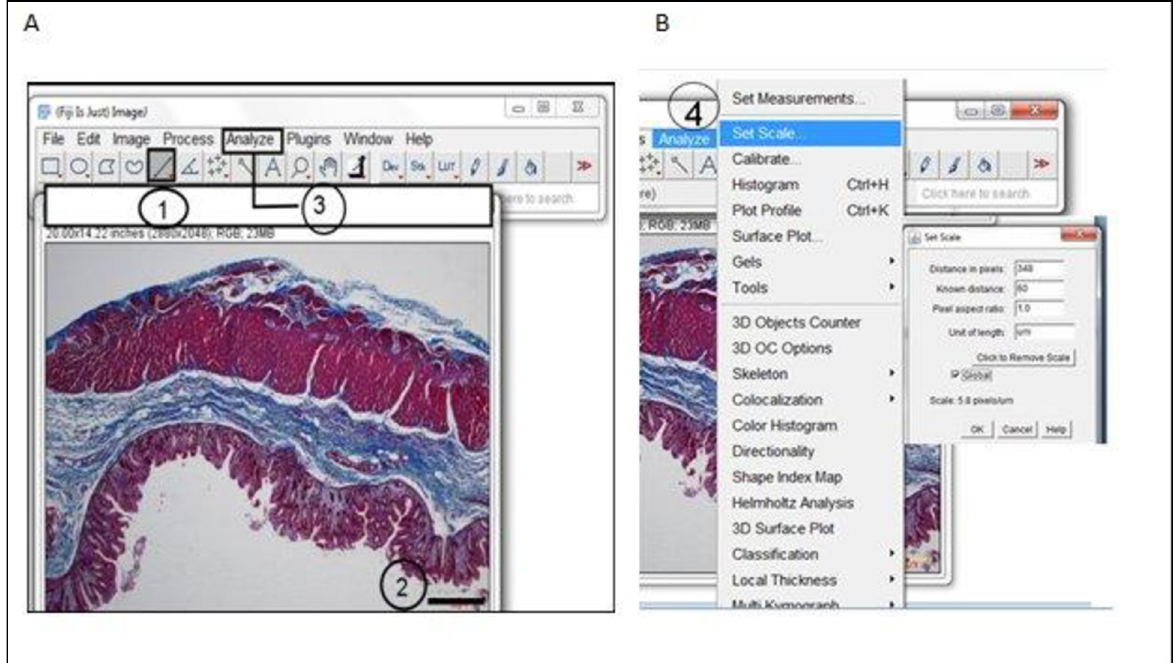
Fig 1. Technique for evaluating colonic samples images with ImageJ programme. The image is first opened, and Scale setting performed by (A): 1 ) The “Straight” line tool is selected, and a straight line is drawn as shown on 2. (B) On the “Analyse” menu ( 3 ), the “Set Scale” ( 4 ) automatically calibrates “Distance in pixels”, the length of the scale bar of 60 is entered into “Known Distance” box, and the unit in μ m was then input in the “Unit of length” box. And when “Global” is checked, all the images for subsequent analysis were automatically scaled to 5.8 pixels/ μ m.